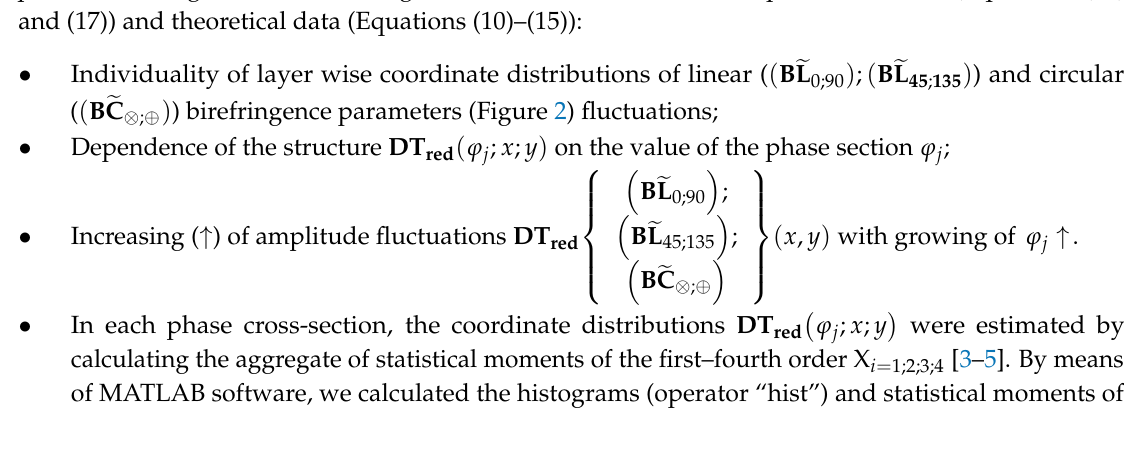
Figure 2. Diffuse tomograms DT red fluctuations of a polycrystalline blood film taken from healthy donors ( τ = 0.71; ∆ = 46% ). Further details are in the text.